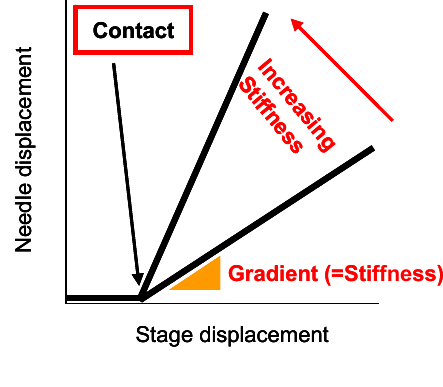
Figure 7. Concept of gradient in plot of needle displacement against stage